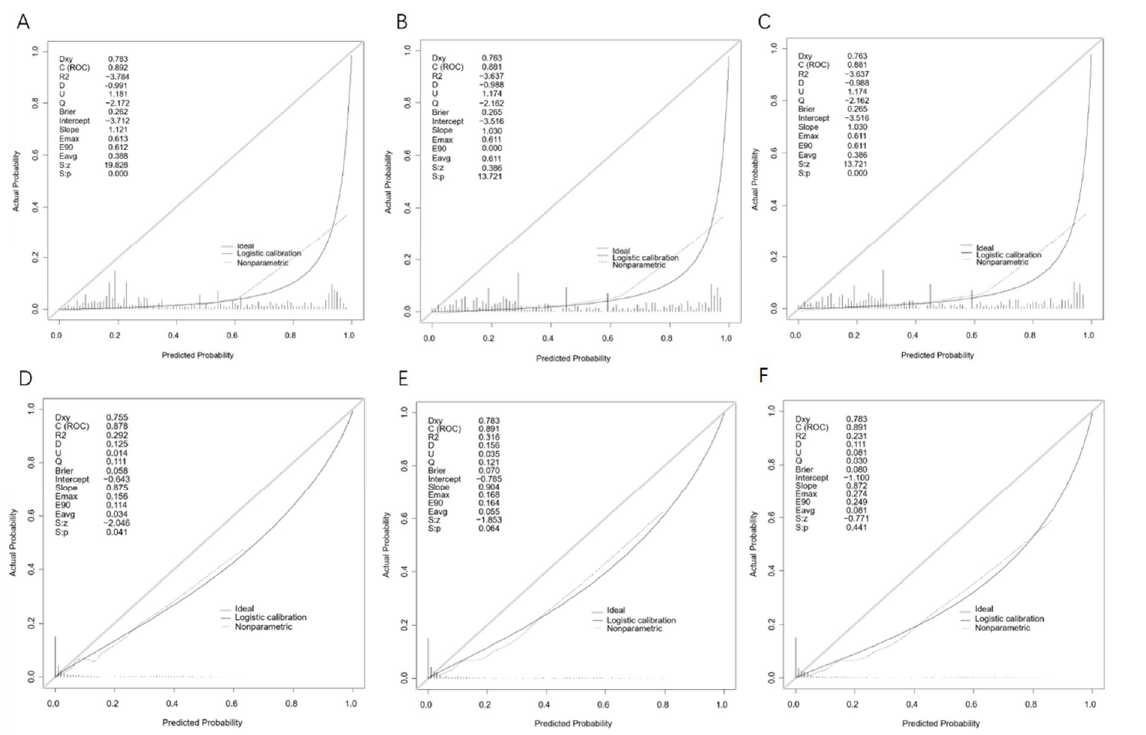
Figure 4. Calibration curves of the Cox-PH ( A – C ) and DeepSurv ( D – F ) models for 3-, 6- and 9-month cancer-specific survival.